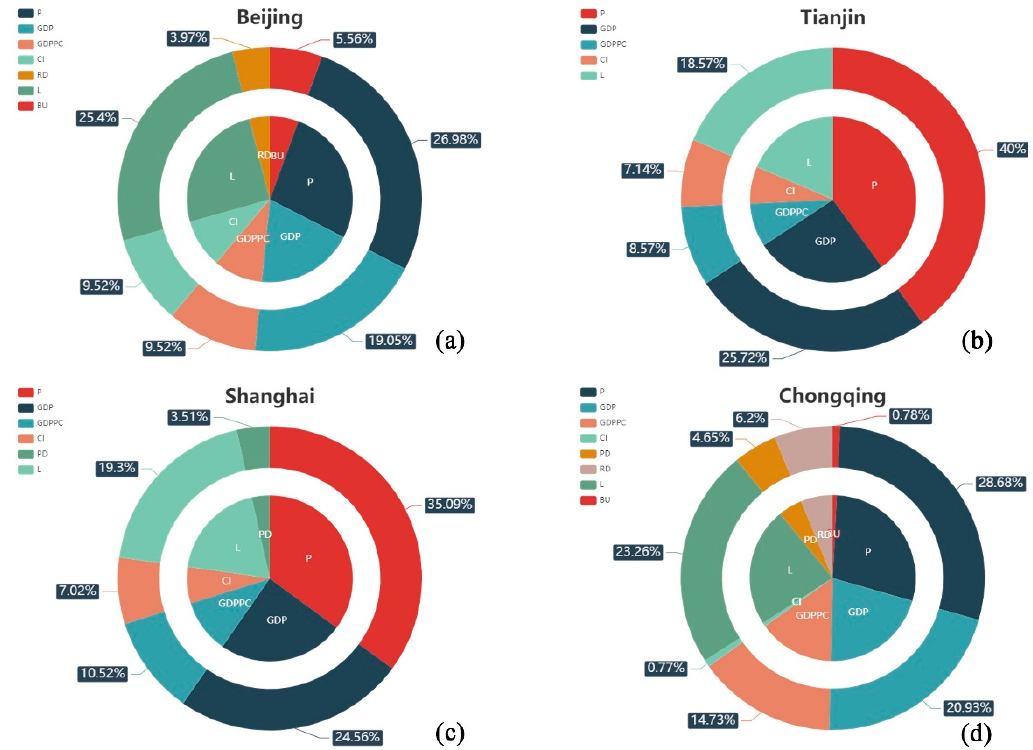
Figure 5. CEPC and influence factors regression results using XGBoost. ( a ) Beijing; ( b ) Tianjin; ( c ) Shanghai; ( d ) Chongqing.4.3. The importance of the influencing factors in single factor.